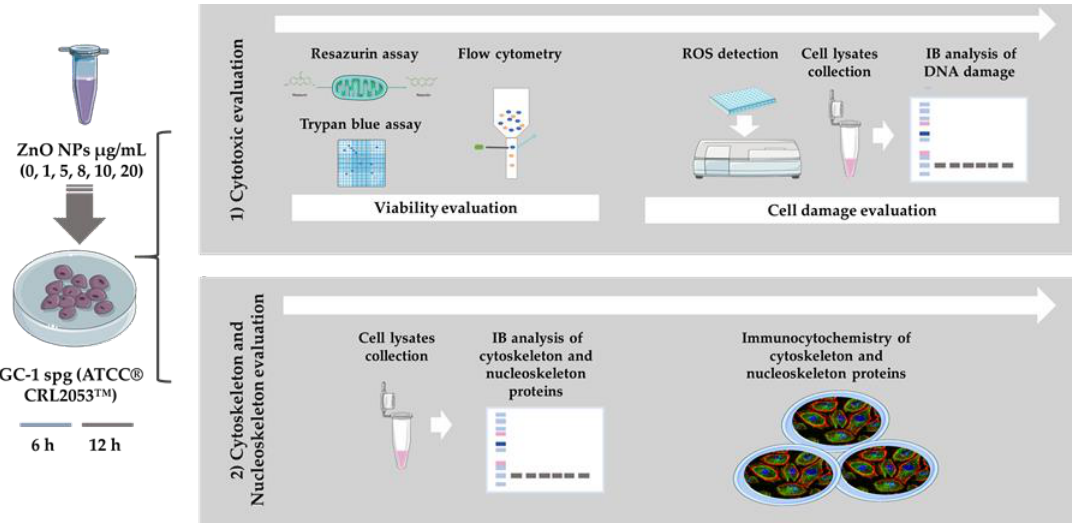
Figure 2. Schematic representation of experimental workflow: Methods used for evaluation of the cytotoxic effects of ZnO NPs in the GC-1 spg cell line (ATCC ® CRL2053™). The study was divided in two stages. Initially, cytotoxicity was evaluated by cell viability and cell damage analysis (oxidative and DNA damage), and then, the alterations of cytoskeleton and nucleoskeleton were also pursued.